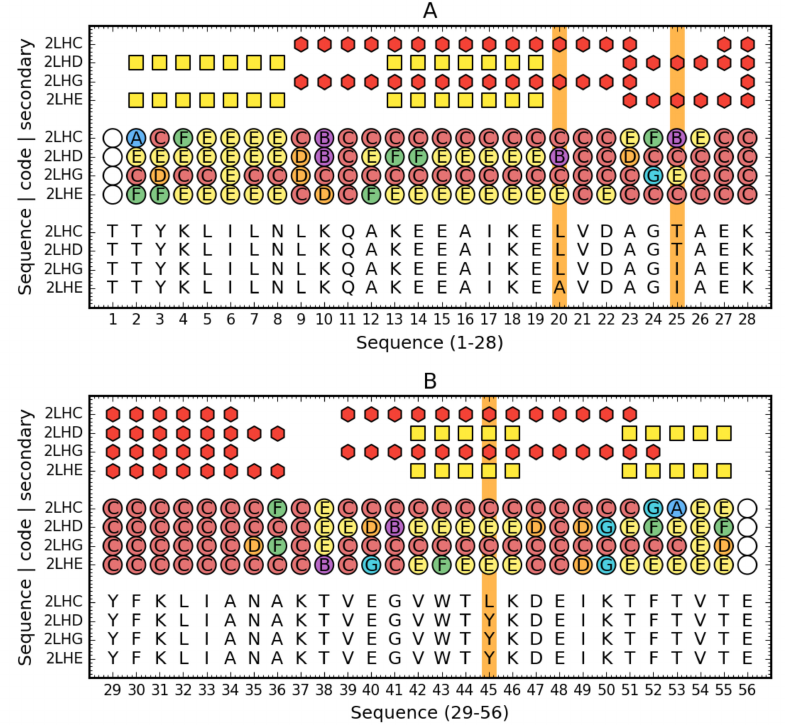
Figure 9. Comparison of Ga98 (2LHC), Gb98 (2LHD), Gb98-T25I (2LHG) and Gb98-T25I,L20A. Top rows: Secondary structure (red hexagons—helix, yellow square—sheet) for three compared proteins. Central rows: Structural codes (names and colors match the system used on Figure 1). Bottom rows: Sequence. Vertical orange line denotes the mutated residues. For readability, sequence is split into two parts (1–28— A , 29–59— B